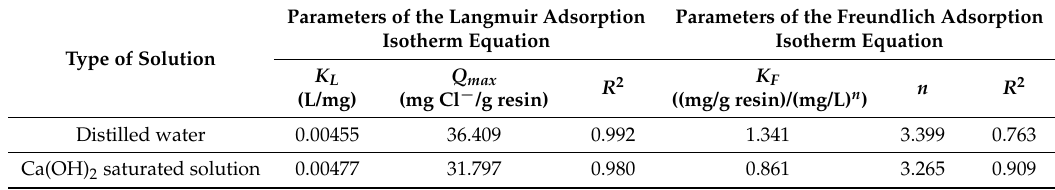
Table 9. Experimental parameters of the Langmuir and Freundlich adsorption isotherm